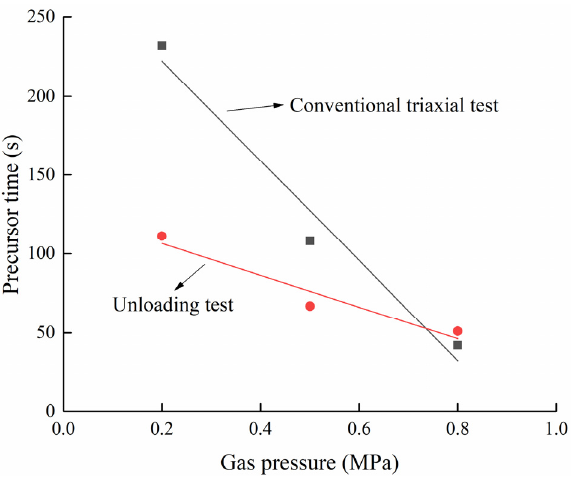
Figure 14. Relationship between precursor signal duration and gas pressure.